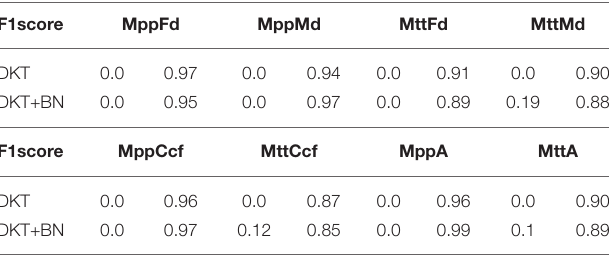
TABLE 3 | The DKT and the DKT+BN on Skills that are easy to